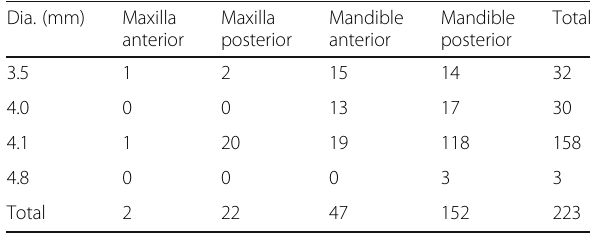
Table 3 Distribution of implants by diameter and